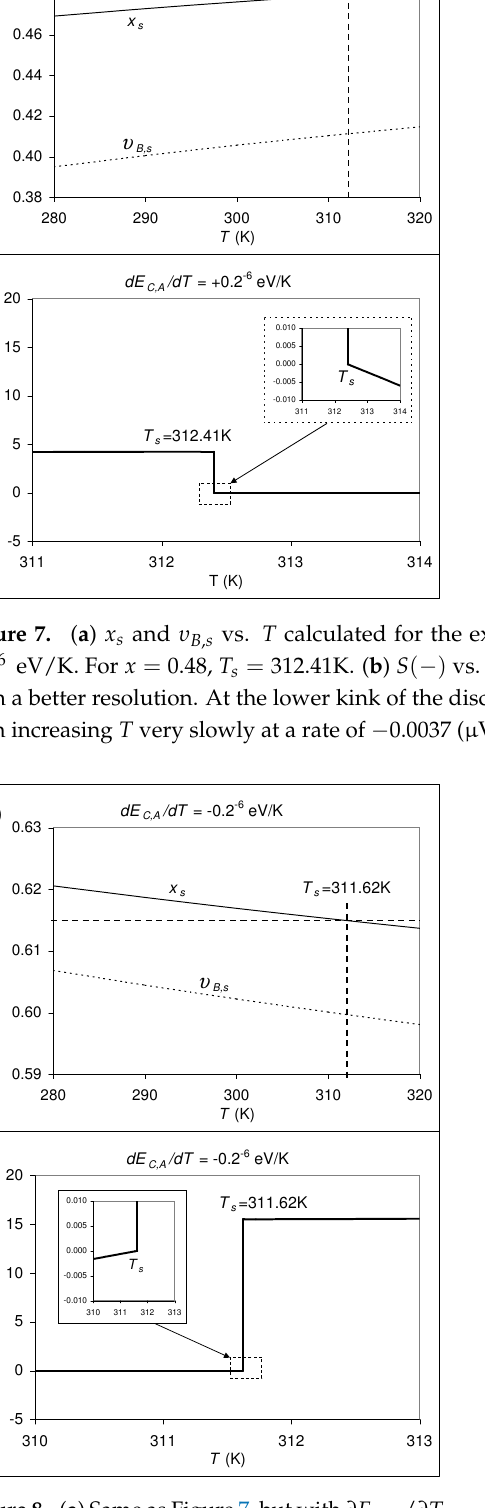
Figure 8. ( a ) Same as Figure 7, but with ∂ E C , A / ∂ T = − 0.2 × 10 − 6 eV/K. For x = 0.615, T s = 311.62K. ( b ) S ( − ) vs. T for x = 0.615. The inset shows the same data with a better resolution. At the lower kink of the discontinuity, S ( − ) = 0 precisely; S ( − ) increases with increasing T very slowly at a rate of 0.001 ( µ V/K) per 1